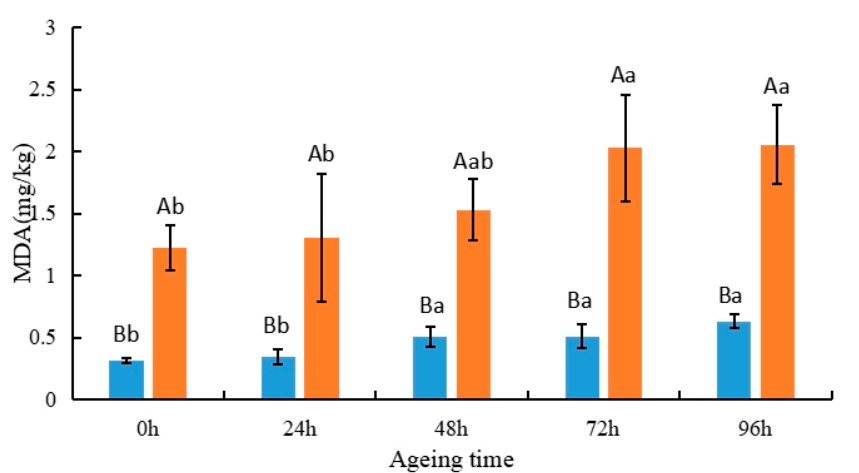
Figure 2. Changes in malondialdehyde content (mg/kg) in the LT muscle of the PF and CF during postmortem aging. The capital letters indicate significant differences in feeding regimes ( p < 0.05), and the lowercase letters represent significant differences at different time points during postmortem aging ( p < 0.05).